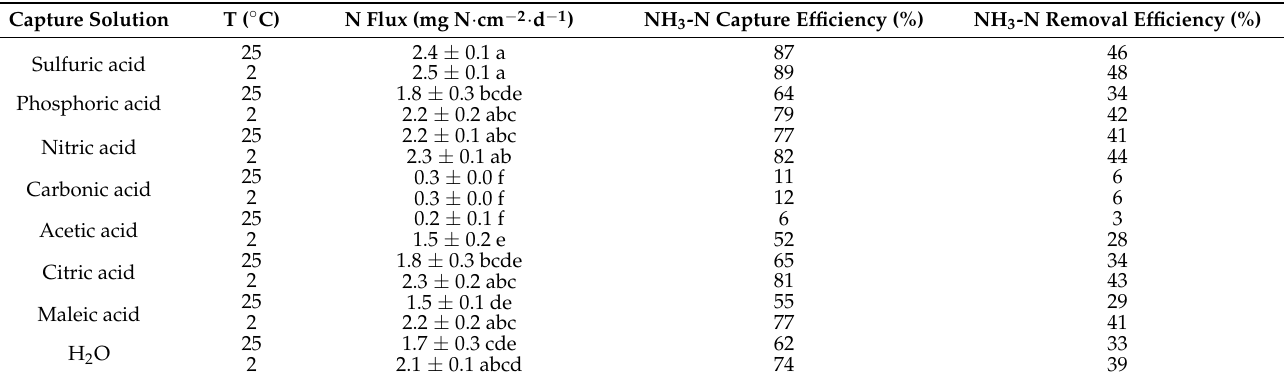
Table 2. NH 3 flux rates (N flux), NH 3 -N capture efficiencies, and overall NH 3 -N removal efficiencies for the different trapping solutions at the two assayed temperatures, 25 and 2 ◦ C, representative of the winter and summer scenarios,